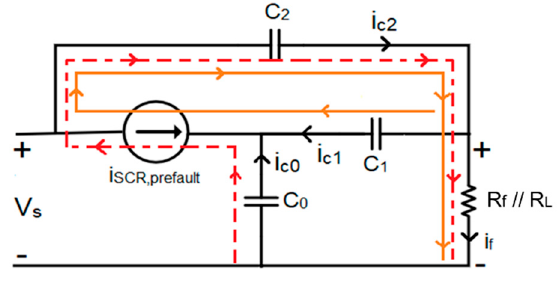
Figure 4. Equivalent circuit of ZCB for the current analysis during the initial instance of fault.